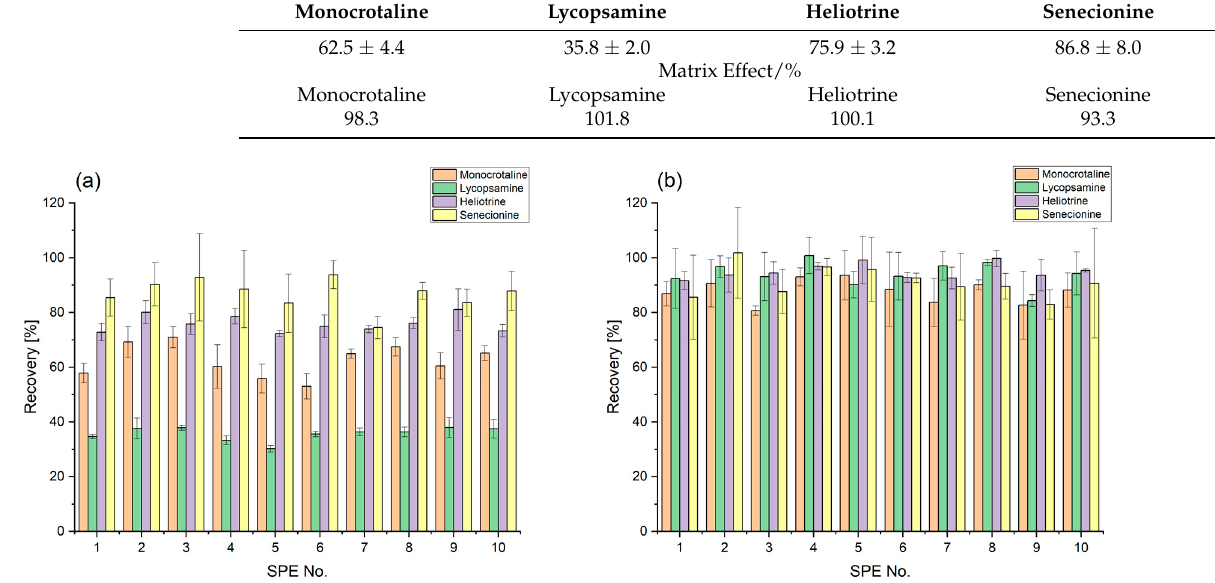
Figure 5. Solid phase extractions of a 12.5 µ g L − 1 spiked honey sample with HNT-PhSO 3 H ( a ) and HNT-MPTMS-SO 3 H ( b ) as solid